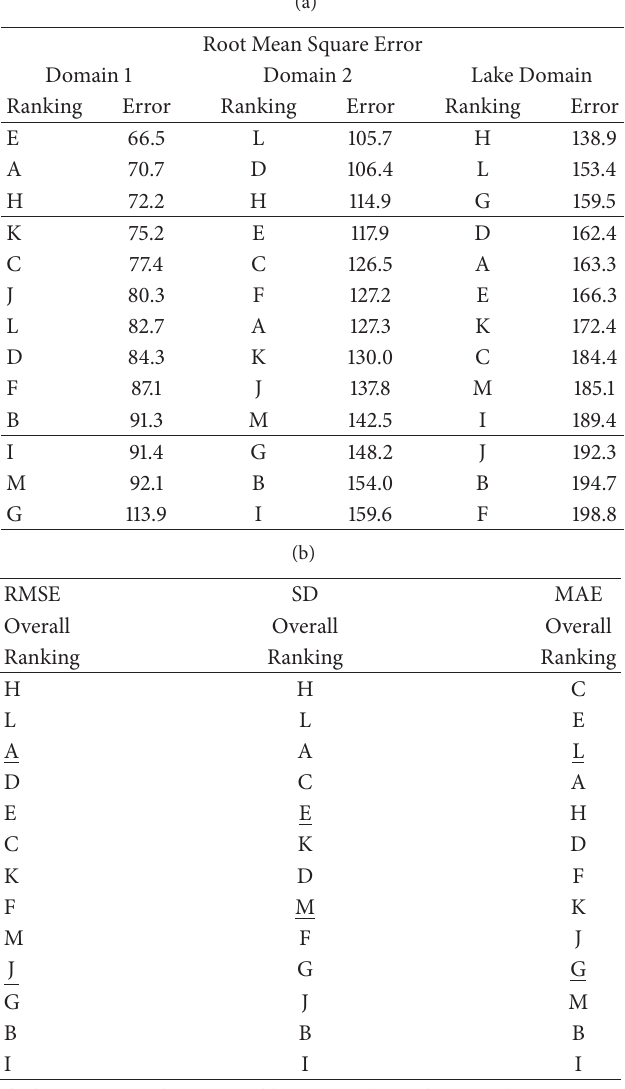
Table 2: (a) The Ranking of all the different runs with their corresponding RMSE (best to worst in descending order) separated by domain. (b) The overall RMSE, SD and MAE ranking based on all the